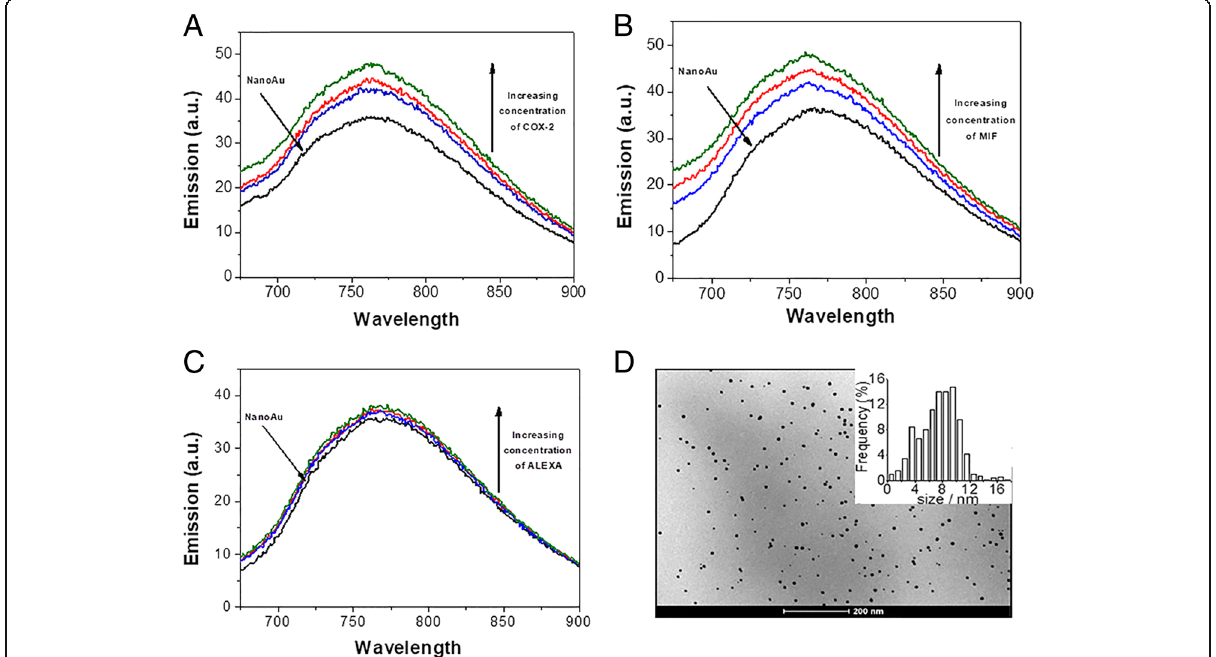
Fig. 6 Fluorescence emission spectra of AuNPs excited at 320nm in the presence of anti-COX-2 ( a ), anti-MIF ( b ), and ALEXA ( c ). The TEM image of the spherical nanoparticles used in this study, showing its size and distribution ( d ). Excitation and emission slits were 10nm. The concentration of AuNPs was held constant at 29.6ng/ml − 1 . The concentrations of antibody are 100ng/ml − 1 (blue curve), 150ng/ml − 1 (red curve), and 200ng/ml − 1 (green